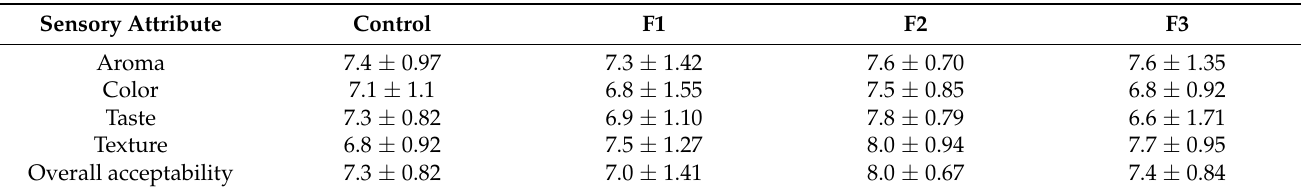
n = 40 panelists. All data were expressed as the mean ± S.D. of sensory score of the aroma, color, taste, texture and overall acceptability of each cookie formulation. Data were analyzed according to a Kruskal–Wallis test followed by Dunn’s multiple comparison test. Statistical significance, p >